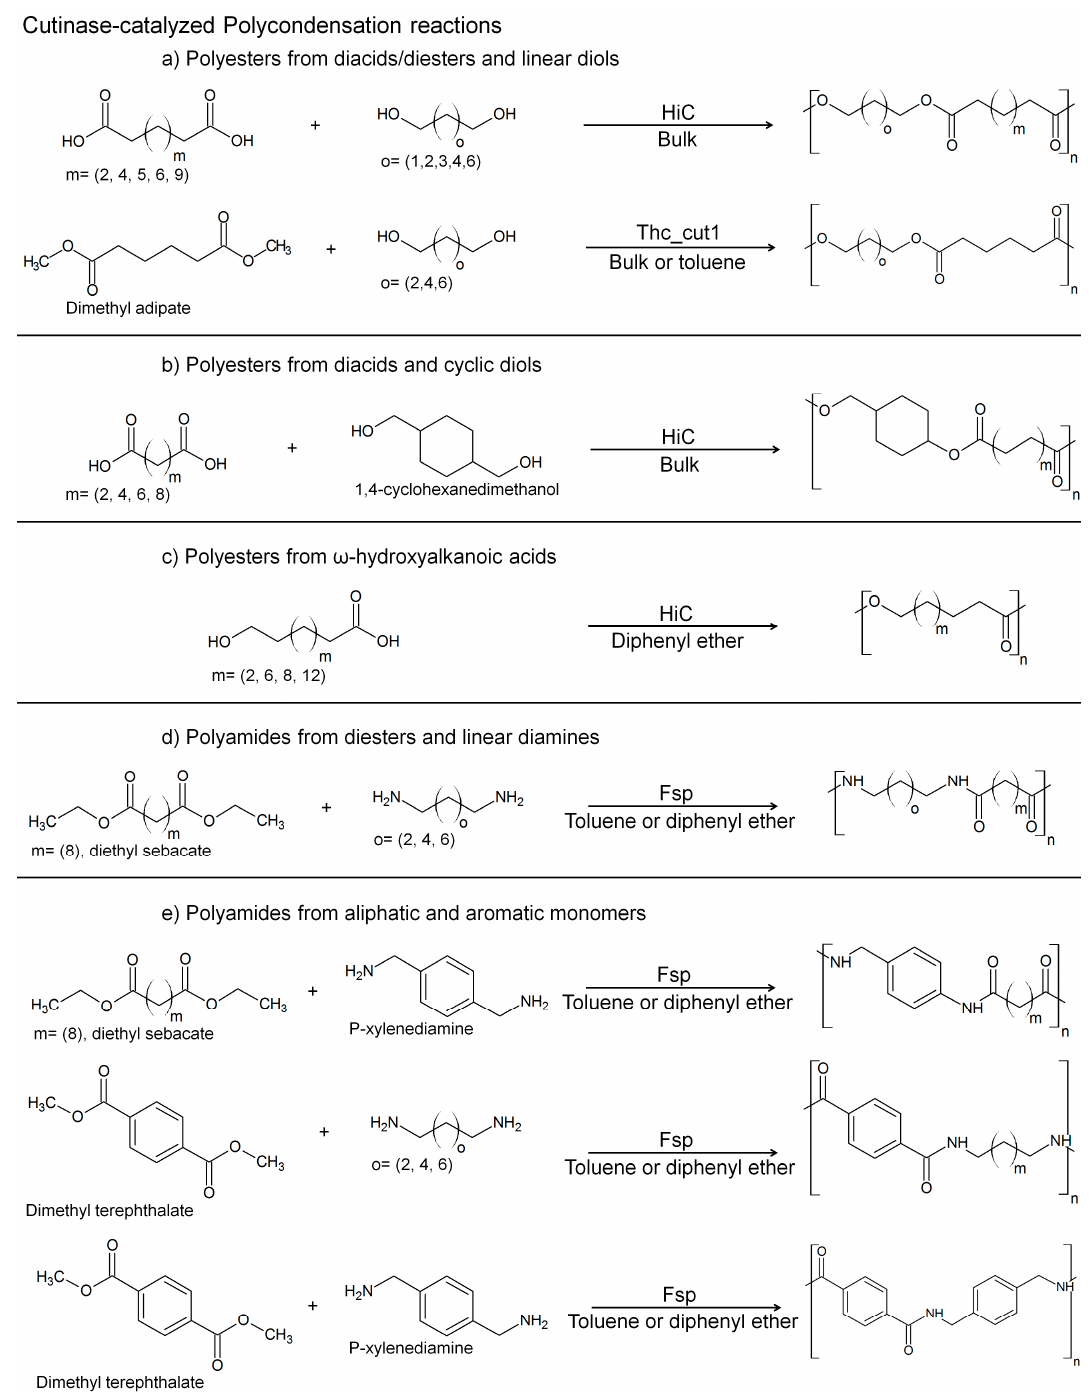
Figure 2. Schematic representation of polymer synthesis catalyzed by the different cutinases discussed in the present section. Fsp: Fusarium solani pisi cutinase; HiC: Humicola insolens cutinase; and Thc_cut1: Thermobifida cellulosilytica cutinase 1. ( a ) polyesters from diacids/diesters and linear diols; ( b ) polyesters from diacids and cyclic diols; ( c ) polyesters from ω‐ hydroxyalkanoic acids; ( d ) polyamides from diesters and linear diamines; ( e ) polyamides from aliphatic and aromatic monomers.